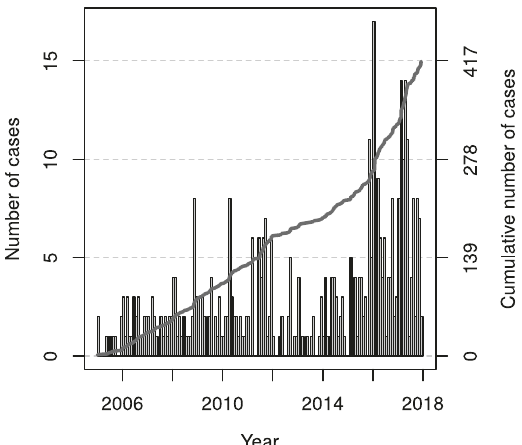
Fig. 1 The number of far-right extremists exposed in the PIRUS database between 2005 and 2017. Number of cases is on the left, and cumulative number of cases is on the